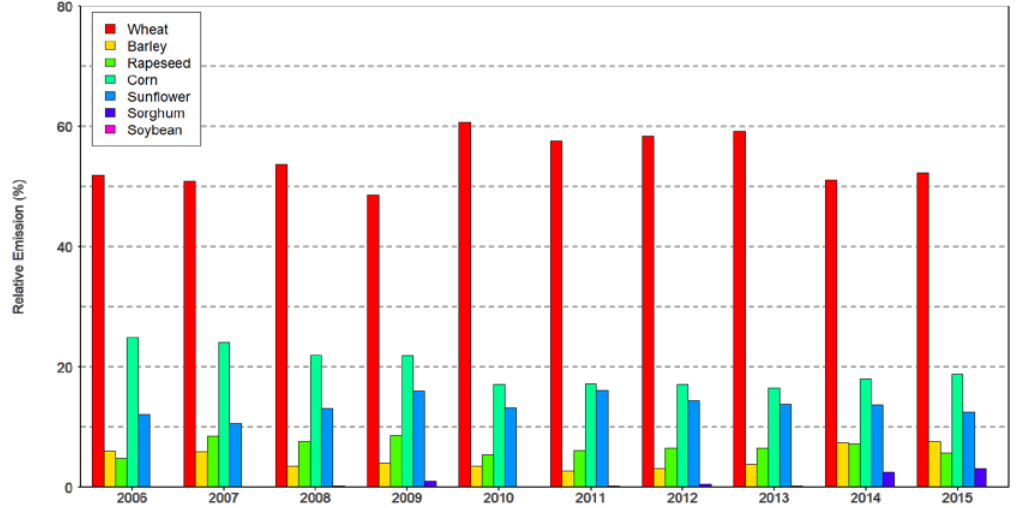
Figure 9. Temporal evolution of the relative emission considering 7 classes: wheat, barley, rapeseed, corn, sunflower, sorghum and soybean (expressed in % of yearly potential budget of N2O emissions estimated over the study area).